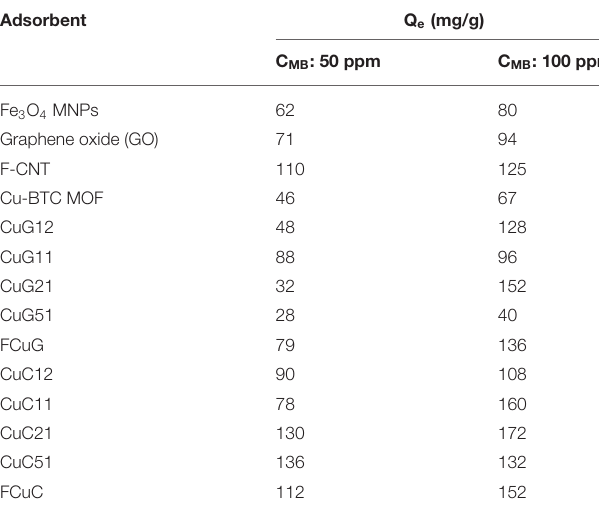
TABLE 4 | Methylene blue (MB) adsorption capacities, Q e in mg/g, of various hybrid nanocomposites. Adsorbent